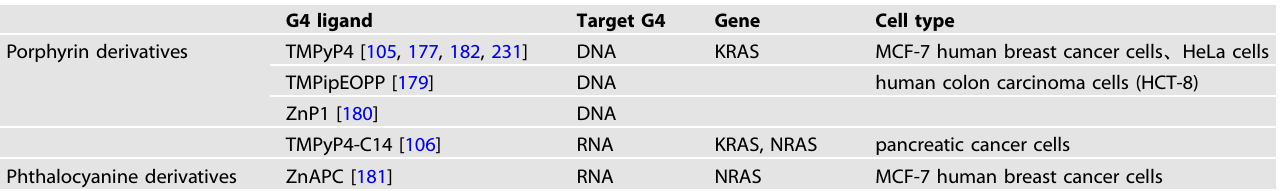
Fig. 7 ROS regulates oncogene expression depend on G4. The ROS in cancer cells oxidizes guanine residues in the oncogene promoter region or mRNA G4s to OG, which activates the G4-mediated DDR pathway and translation. The transcription and translation of oncogenes promot cancer development. Table 2. G4-targeting